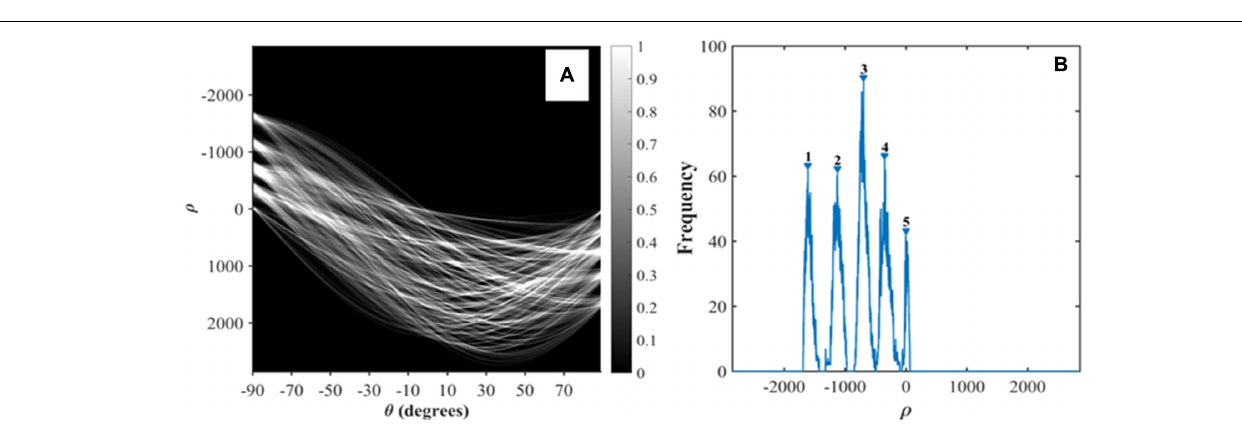
FIGURE 3 | Hough transform to detect rows. (A) Hough transform. (B) Identification of the peaks of ρ corresponding to the